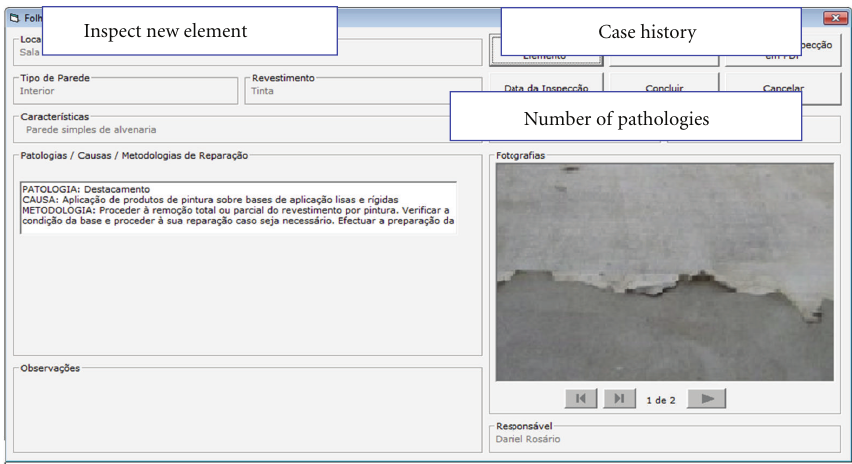
Figure 4: Presentation of the information introduced into the inspection sheet.